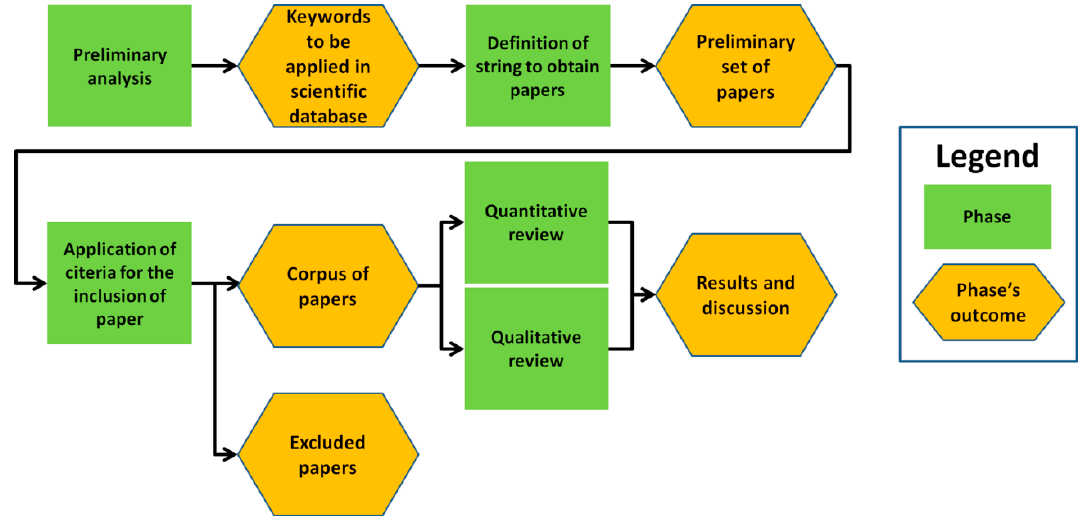
Figure 1. General methodological framework of the study.